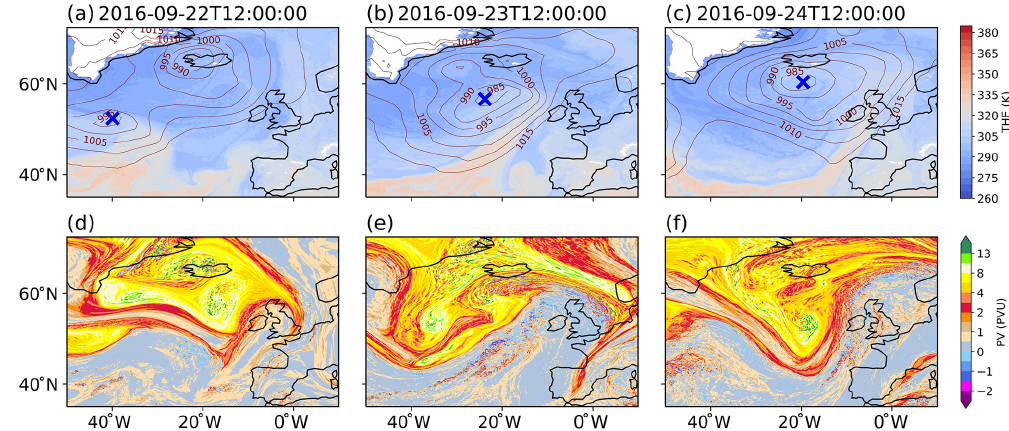
Figure 1. Synoptic evolution of cyclone Vladiana from 22 September 2016 at 12:00 to 24 September 2016 at 12:00. (a–c) Equivalent potential temperature (THE) at 850hPa (color shading) and mean sea level pressure (contour lines, units of hPa). The cyclone position as given by the minimum sea level pressure is shown by the blue cross. (d–f) Potential vorticity (PV) on the 320K isentrope. The figure is based on the 2.5km EC simulation with one-moment cloud microphysics. For PV the same color scale is used as in Fig. 2 of Oertel et al. (2020) for easier